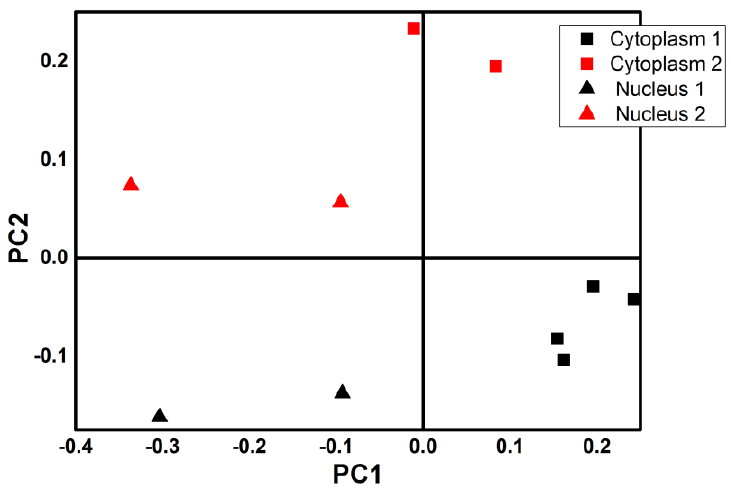
Figure 13. Score plot of PCA analysis on cellular compartments of melanoma cells in PC space. The first two components have been considered: points represent spectra from cell1 (black) and from cell2 (red), from nuclear areas (up triangle) or from cytoplasm